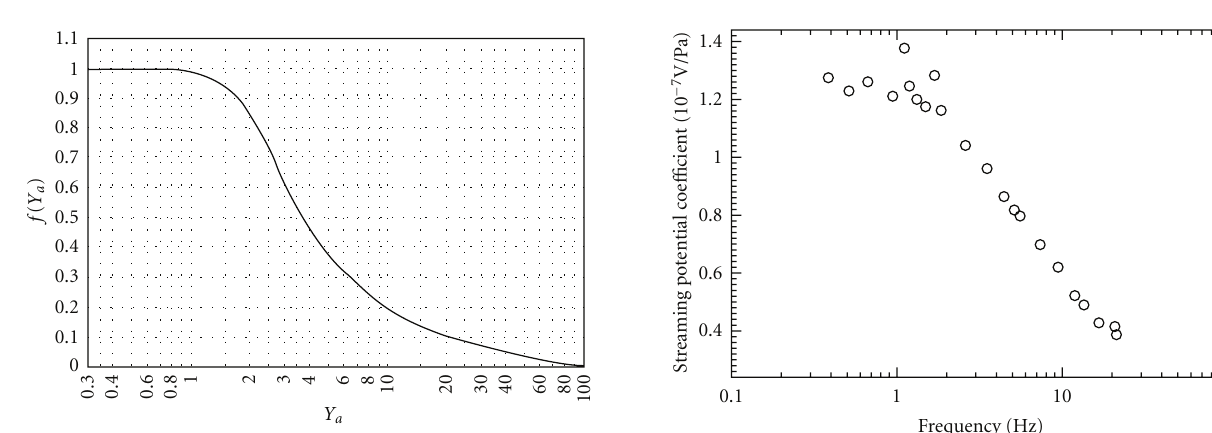
when in contact with the sample, and the p H can change.